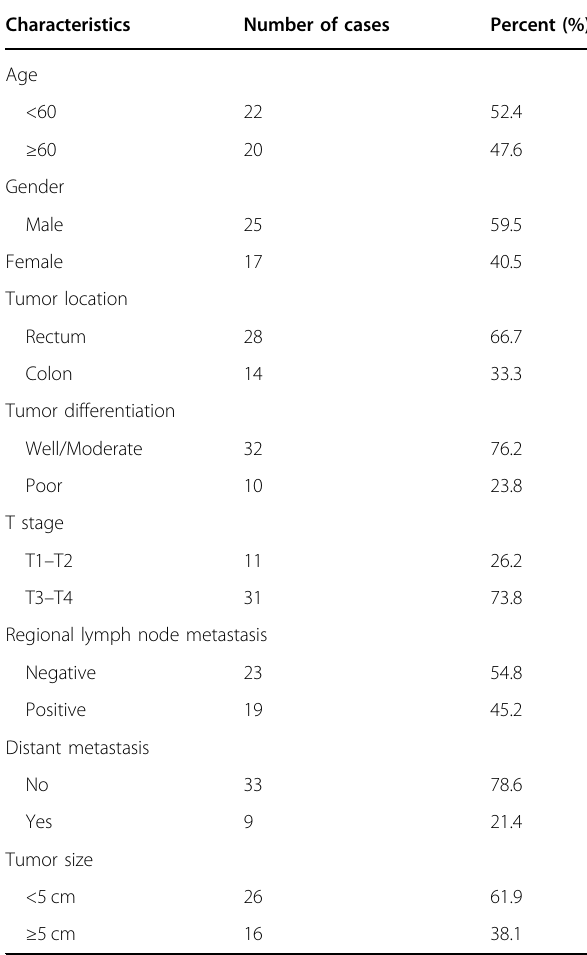
Table 1 Clinicopathological characteristics in patients with CRC ( n =